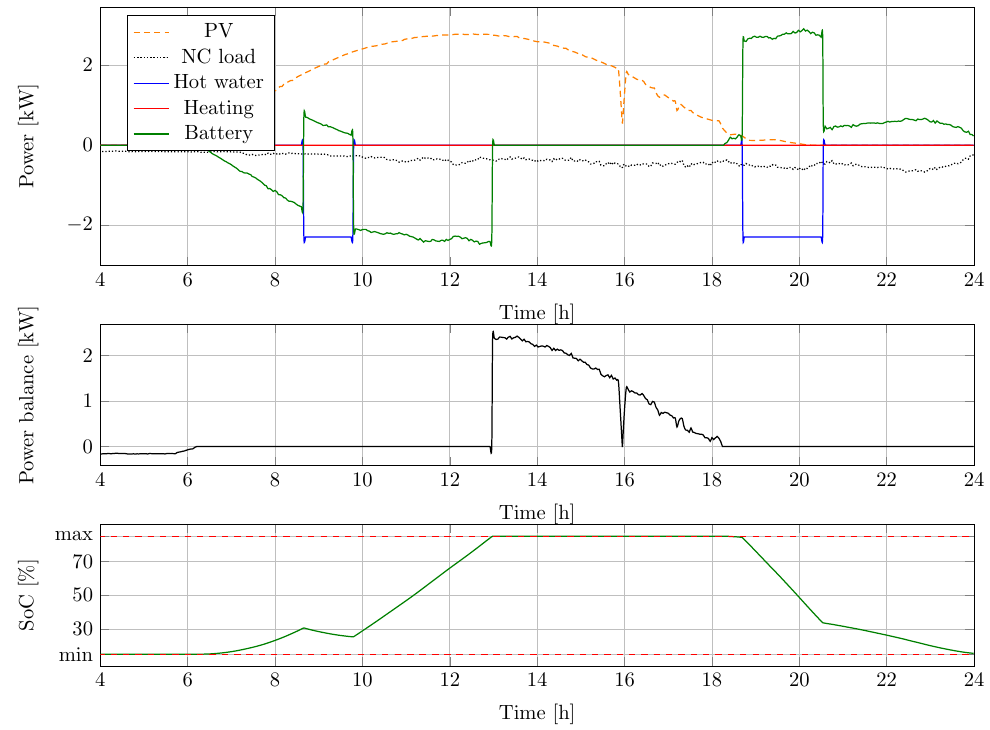
Figure 11. Power consumption/generation of devices for the summer sunny day